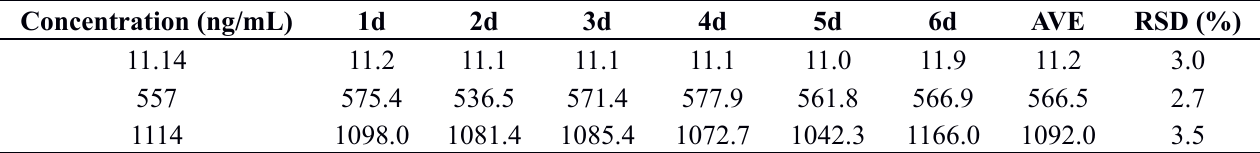
Table 5. Inter-day precision for the analysis of TA-III ( n =